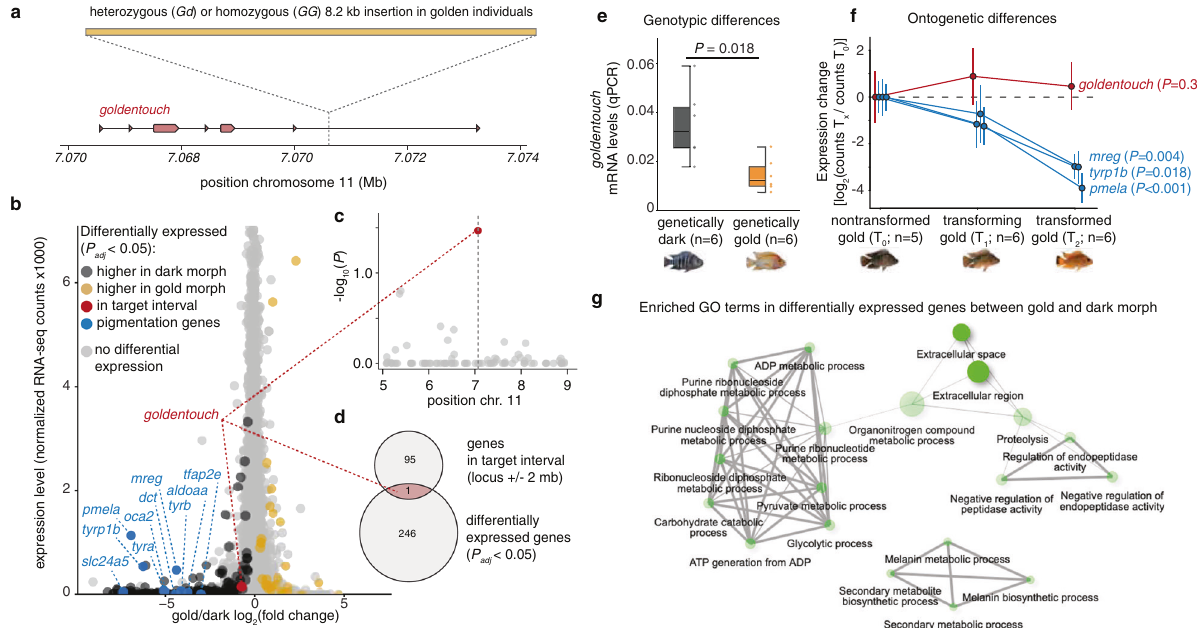
Fig. 2 The genetic basis of the gold/dark polymorphism. a The structural variant that likely underlies the gold/dark polymorphism is an 8.2 kb transposon insertion in the last intron of an heretoforth undescribed gene that we here coin goldentouch . b – d RNA-seq on scales of adult fi sh reveals 247 differentially expressed genes between gold and dark individuals ( P adj < 0.05; Benjamini – Hochberg adjusted Wald test P -value), including several pigmentation genes ( b ). The gene goldentouch is the only differentially expressed gene found within a 4 Mb interval around the insertion ( c, d ). e Quantitative PCR con fi rms the decreased expression of goldentouch in golden individuals (center line, median; box limits, upper and lower quartiles; whiskers, 1.5× interquartile range; points, data points; Welch ’ s two-sample t -test, two-sided). f Relative change of gene expression during ontogeny in golden individuals. Expression of goldentouch (red) remains relatively stable, compared to melanophore marker genes (blue) that decrease in expression due to cell death of the melanophores in which they are expressed (data are presented as mean values± SD; statistical test: one-way ANOVA). g Gene ontology (GO) term enrichment analysis of genes differentially expressed between gold and dark